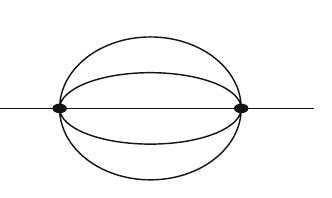
Fig. 5 Leading order topologies for φ